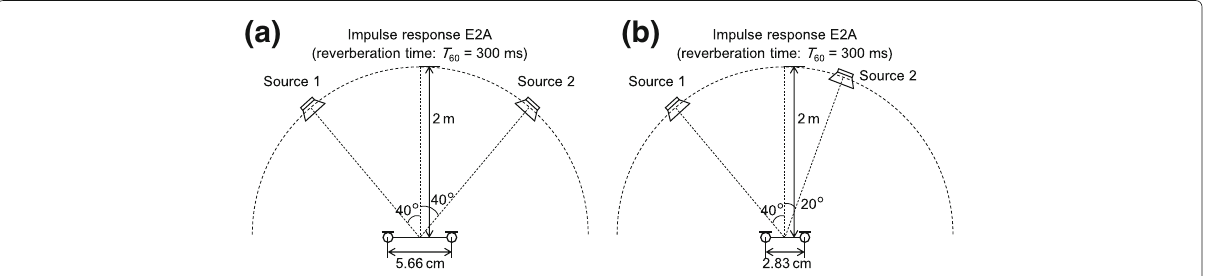
Fig. 6 Spatial arrangements of impulse responses used in two-source case: a E2A_1 and b E2A_2 . Since the microphone spacing and the angle between the two sources in E2A_2 are smaller than those in E2A_1 , BSS is more difficult for E2A_2